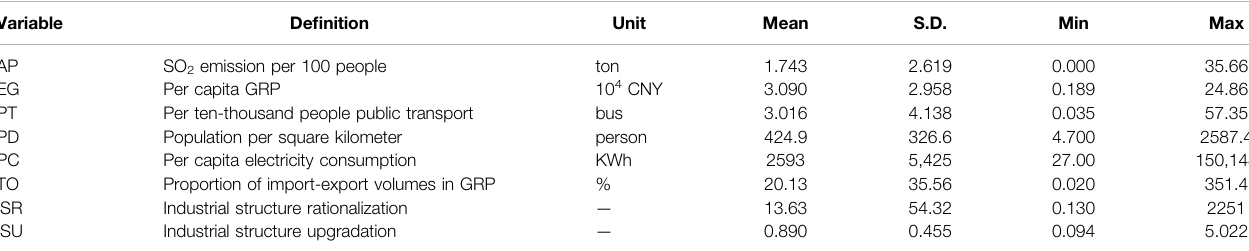
TABLE 1 | Summary statistics.